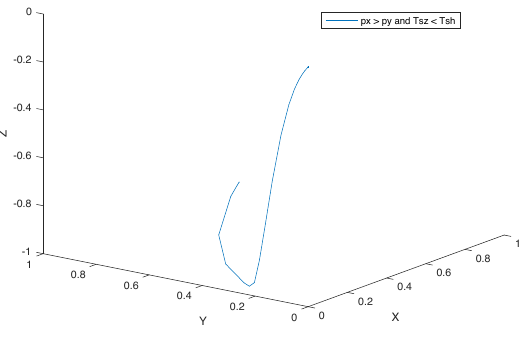
Figure 41. Trajectories in the ( x , y , z ) plane considering p x > p y and that the the behaviour in the vertical coordinate z is faster than the behaviour in the horizontal plane. There is convergence for the reference ( 0,0,0 ) on all